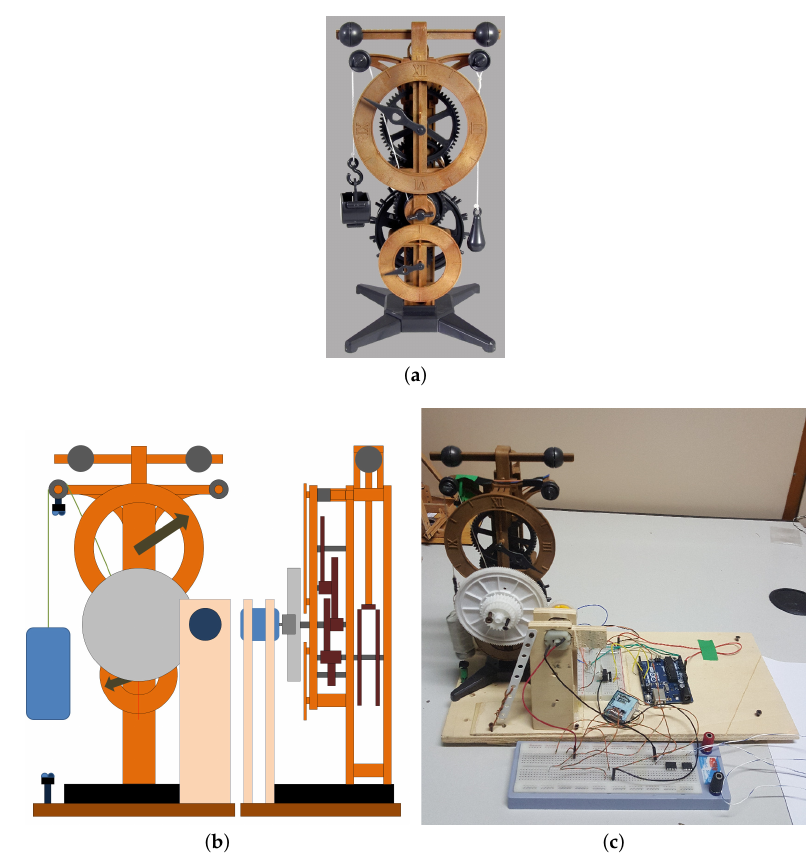
Figure 2. Machine 2, the Mechanical Clock: Leonardo clock original model ( a ); scheme of the automated setup ( b ); picture of the automated clock setup ( c